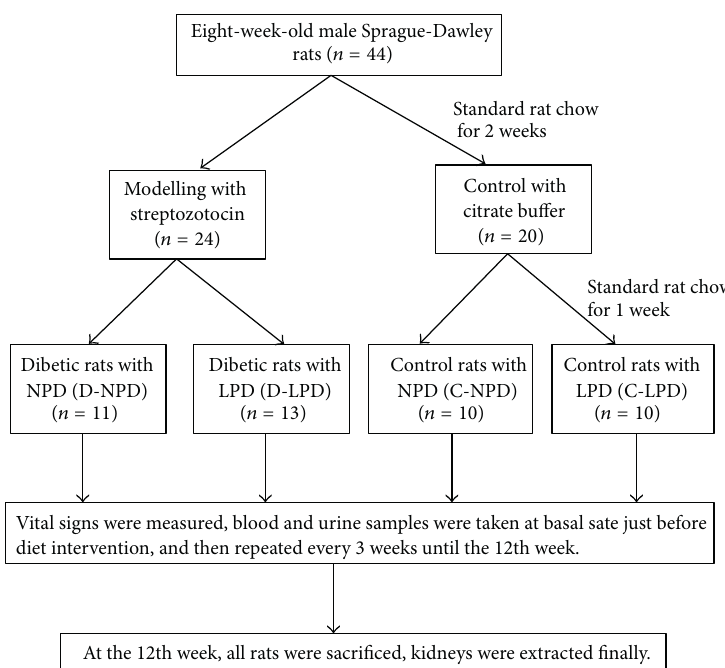
Figure 1: Schematic protocol of the overall animal experiment. NPD: normal protein diet, LPD: low protein